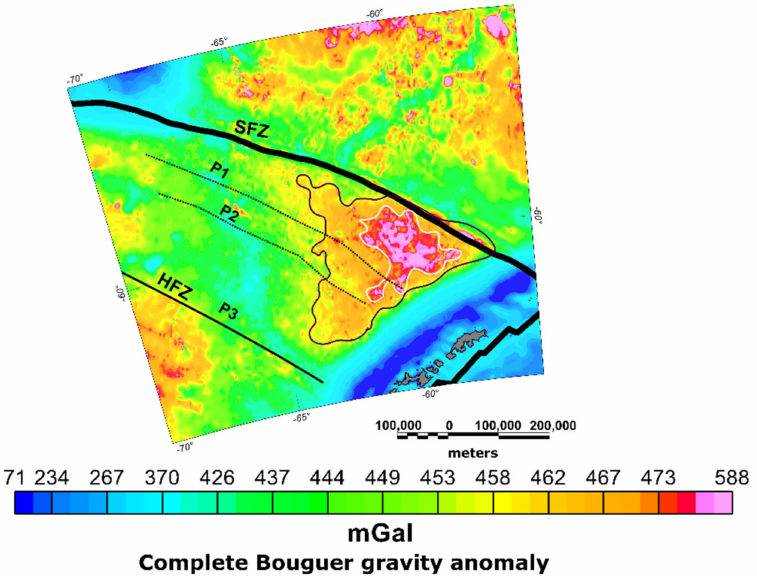
Figure 3. Complete Bouguer gravity anomaly map. Plate boundaries are represented by black solid thick lines. A black solid polygon denotes the location of a triangular high anomaly area, and a white curvilinear polygon denotes the area where highest values of Bouguer anomalies are found. P1, P2, and P3 denote the three inactive plate segments of the Phoenix Ridge and are located over their respective ridges. Two black thin dotted lines separate P1, P2, and P3 zones. HFZ: Hero Fracture Zone. SFZ: Shackleton Fracture Zone. Both fracture zones are depicted with thick and thin black lines, respectively.